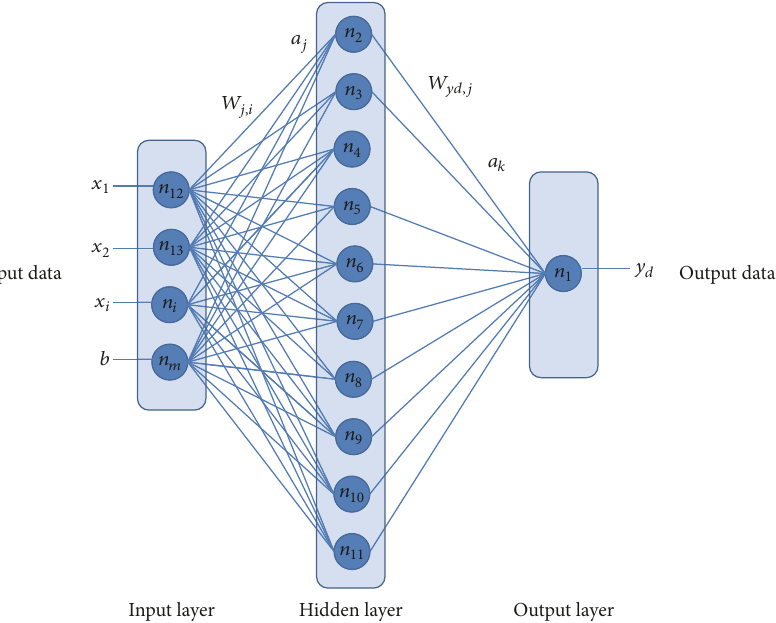
Figure 3: ANN regression trained with back-propagation perceptron